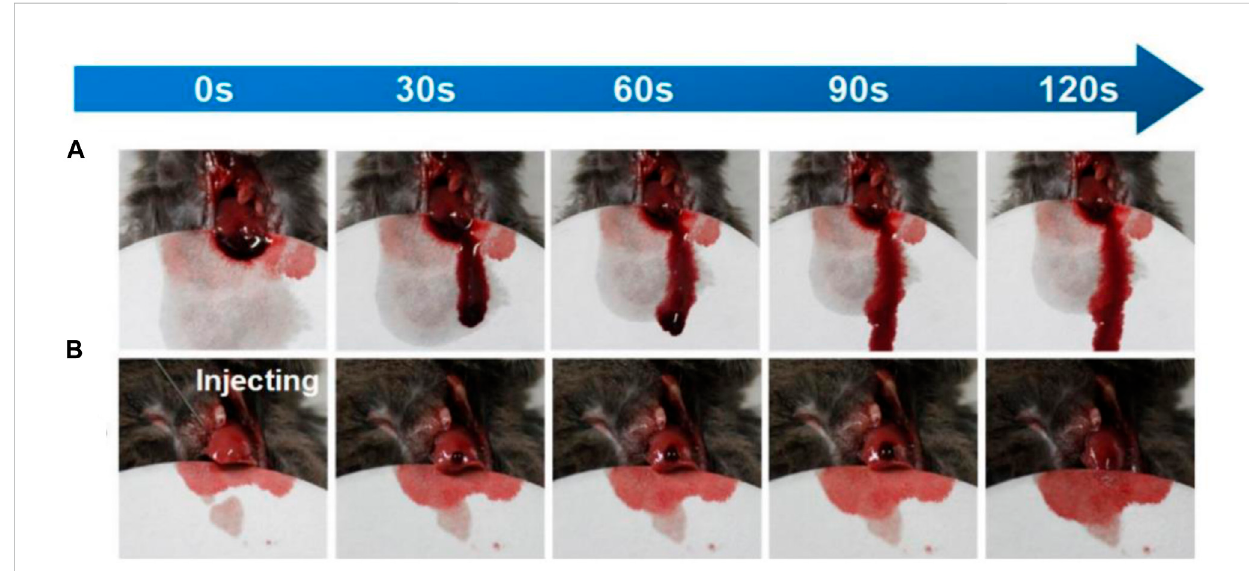
FIGURE 4 Theamountofbleedinginthemouseliverovertime (A) withoutand (B) withgel.Reprintedwithpermissionfrom(Shouetal.,2020).Copyright2020 American Chemical